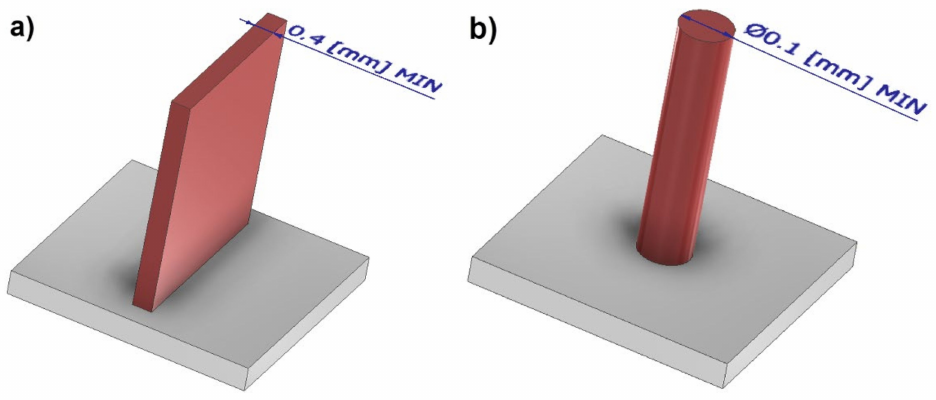
Figure 1. Elements with small cross-sections: ( a ) cuboidal; ( b )